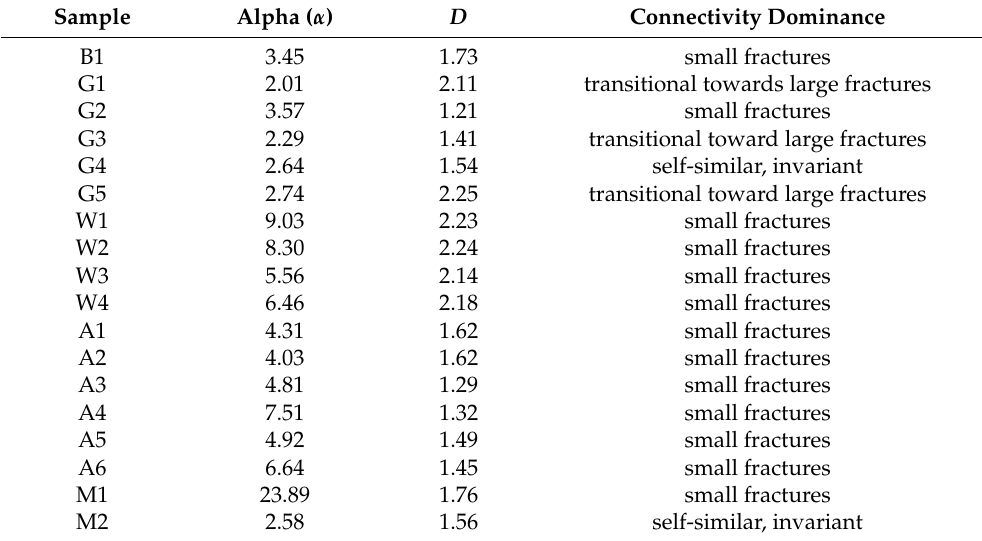
Table 2. Connectivity results.